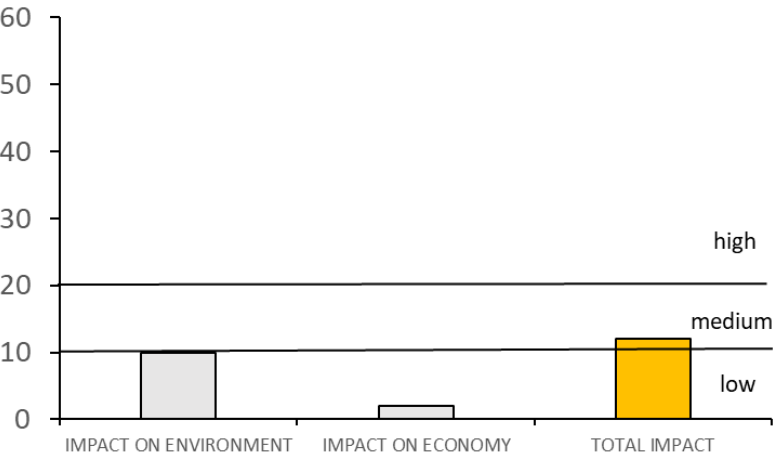
Figure 5. Results of the GISS impact assessment protocol on D. villosus in the River Adda. 0 = no impact; 60 = highest impact. Species with scores > 20 (high risk). The colour yellow indicates a medium level of invasiveness accordingly to the thresholds proposed by [44].